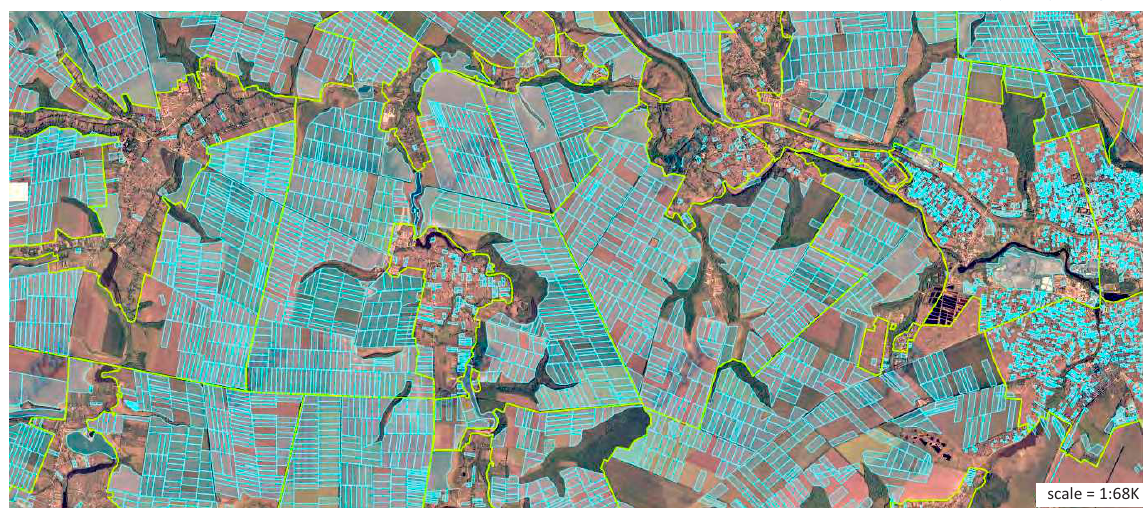
Figure 3. Cadastral map of key plot